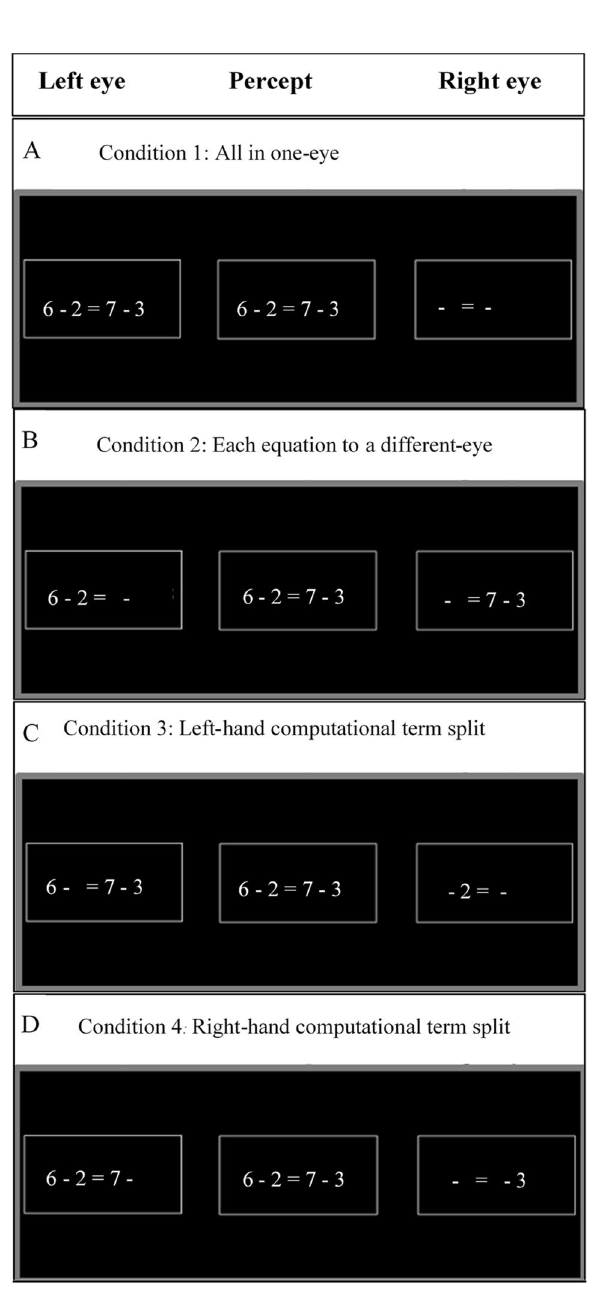
Figure 5. The verification task in which participants were asked to solve equations (by subtraction and addition). The four eye-of-origin conditions were: ( A ) all in one-eye; ( B ) each equation in a different-eye; ( C ) left-hand computational term split; ( D ) right-hand computational term